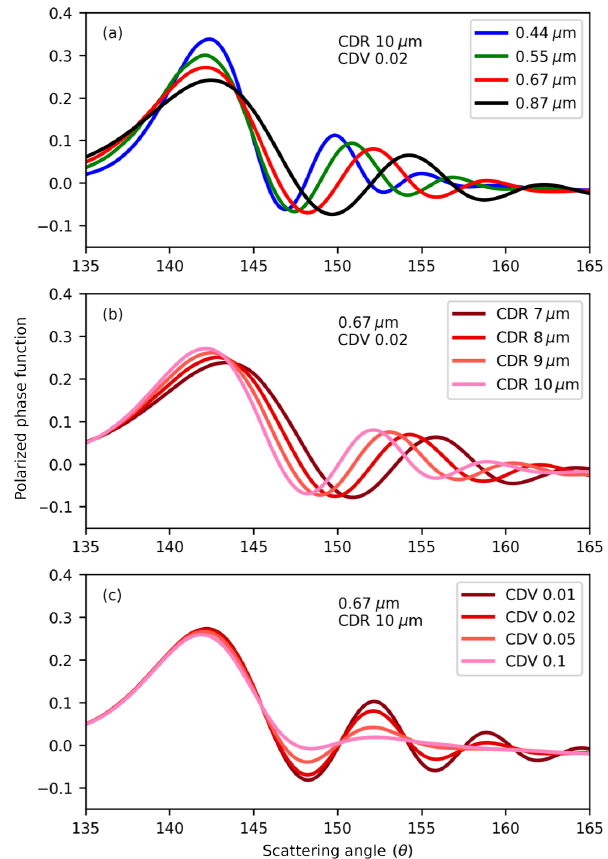
Figure 1. Mie scattering simulations for liquid water cloud droplets, with solar light incident, for the four HARP wavelengths at 10µm CDR and 0.02 CDV (a) , the 0.67µm channel for variable CDR and constant CDV (b) , and constant CDR with variable CDV (c)